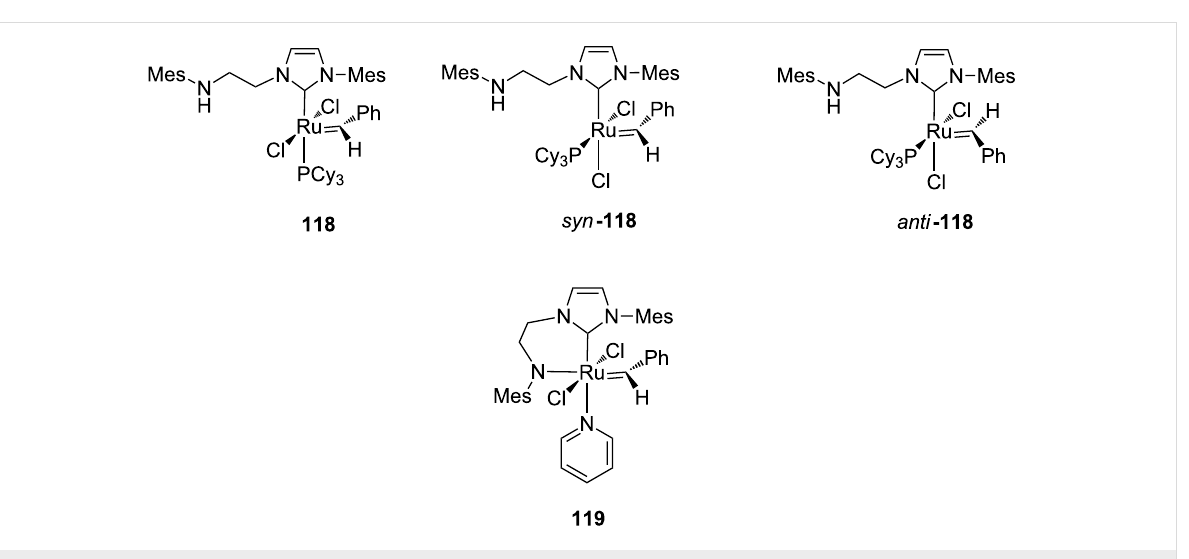
Figure 22: Complexes 118 and 119 bearing a hemilabile amino-tethered